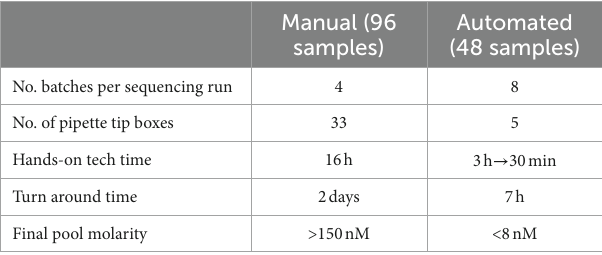
TABLE 2 Comparison of manual vs. automated library preparations. Manual (96